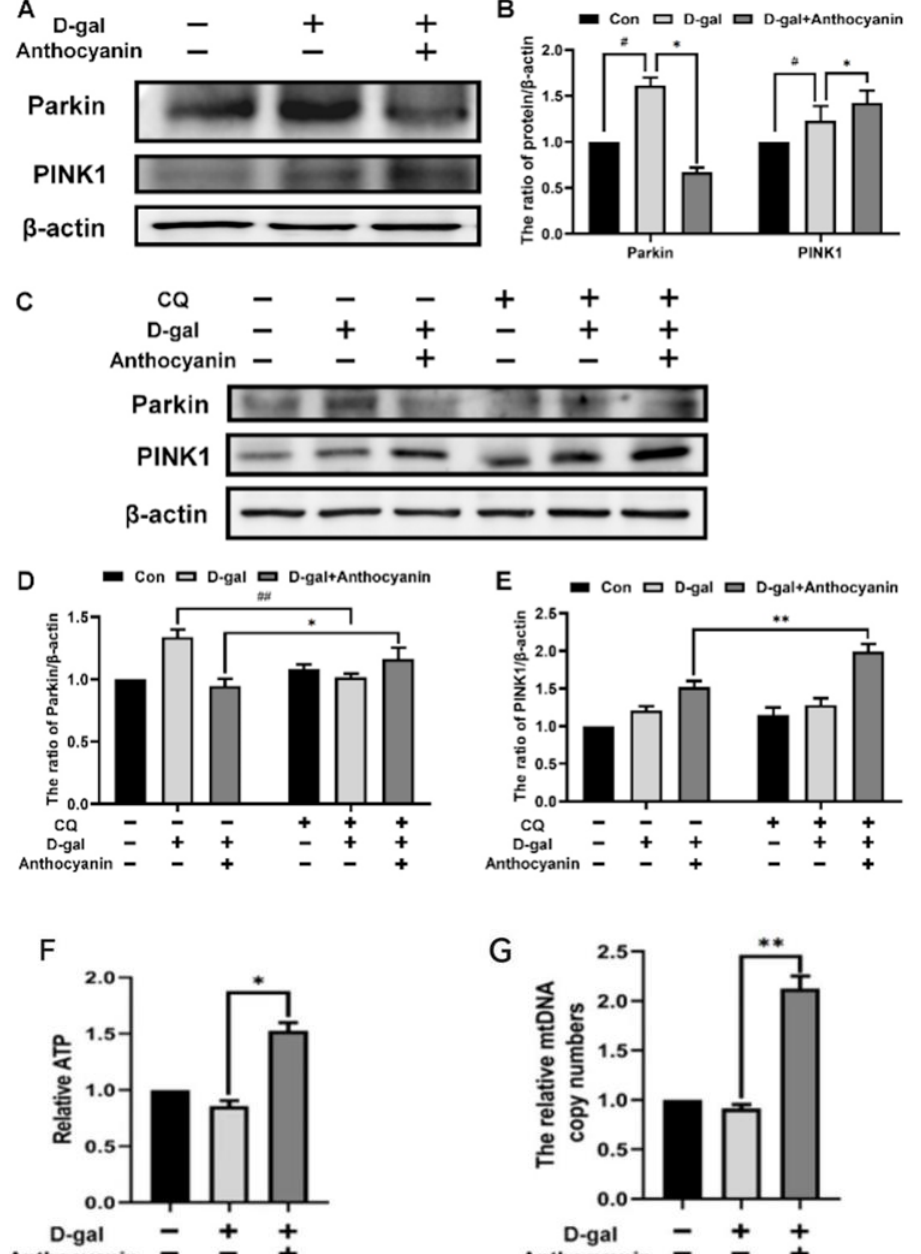
Figure 7. Anthocyanin improved the mitochondrial function of senescent cells. Cells were treated with 40 mM D-galactose alone or in combination with 80 µ g/mL anthocyanin and CQ for 72 h. ( A – E ) The expressions of PINK1 and Parkin were measured using western blot. ( F ) The analysis of the intracellular ATP concentration. ( G ) The relative mtDNA copy numbers. Data are presented as mean ± SD, n = 3. * p < 0.05, ** p < 0.01, # p < 0.05, ## p < 0.01.